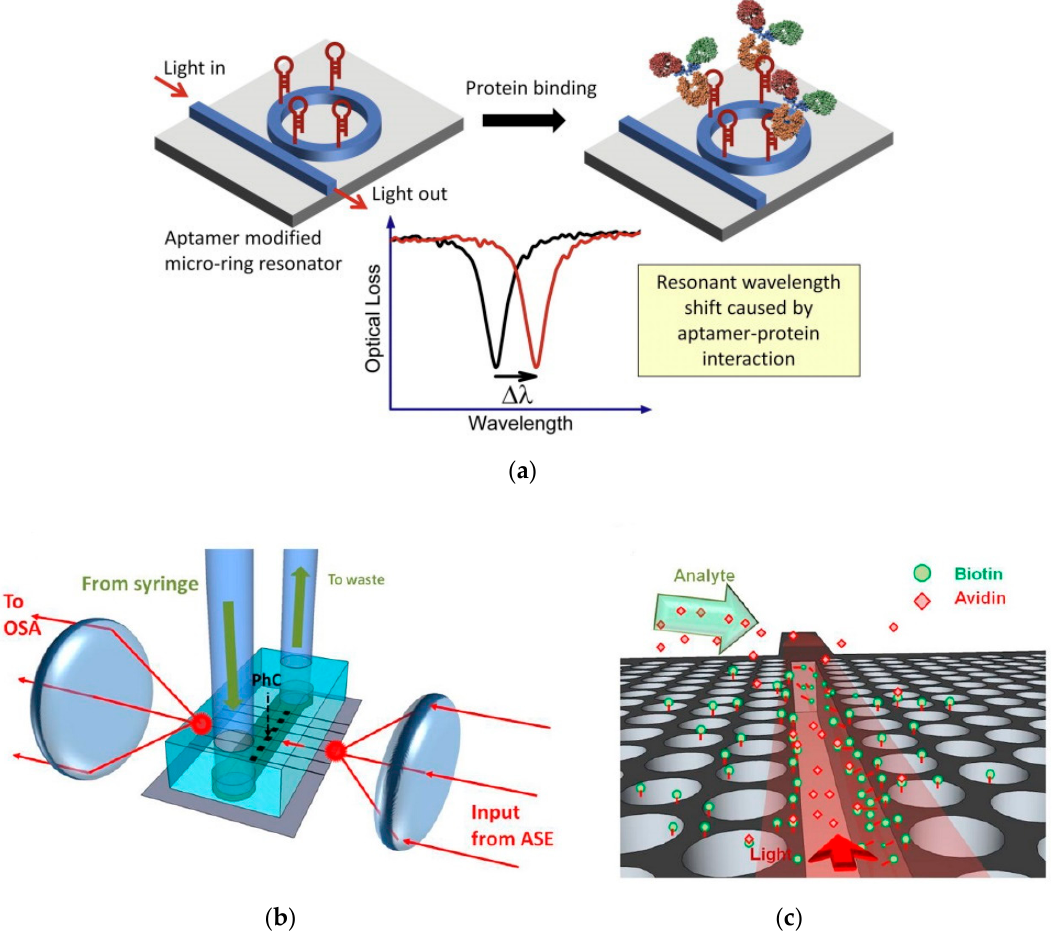
Figure 3. Schematic of semiconductor cavity-based sensors. ( a ) Ring resonator sensor. Reprinted with permission from [89]. Copyright © Elsevier (2012). ( b , c ) Slotted photonic crystal cavity sensor. Reprinted from [118] under CC BY 3.0. Both types of sensors require external measuring equipment such as optical spectrum analyzers (OSA) to measure the small magnitudes of the wavelength shift.